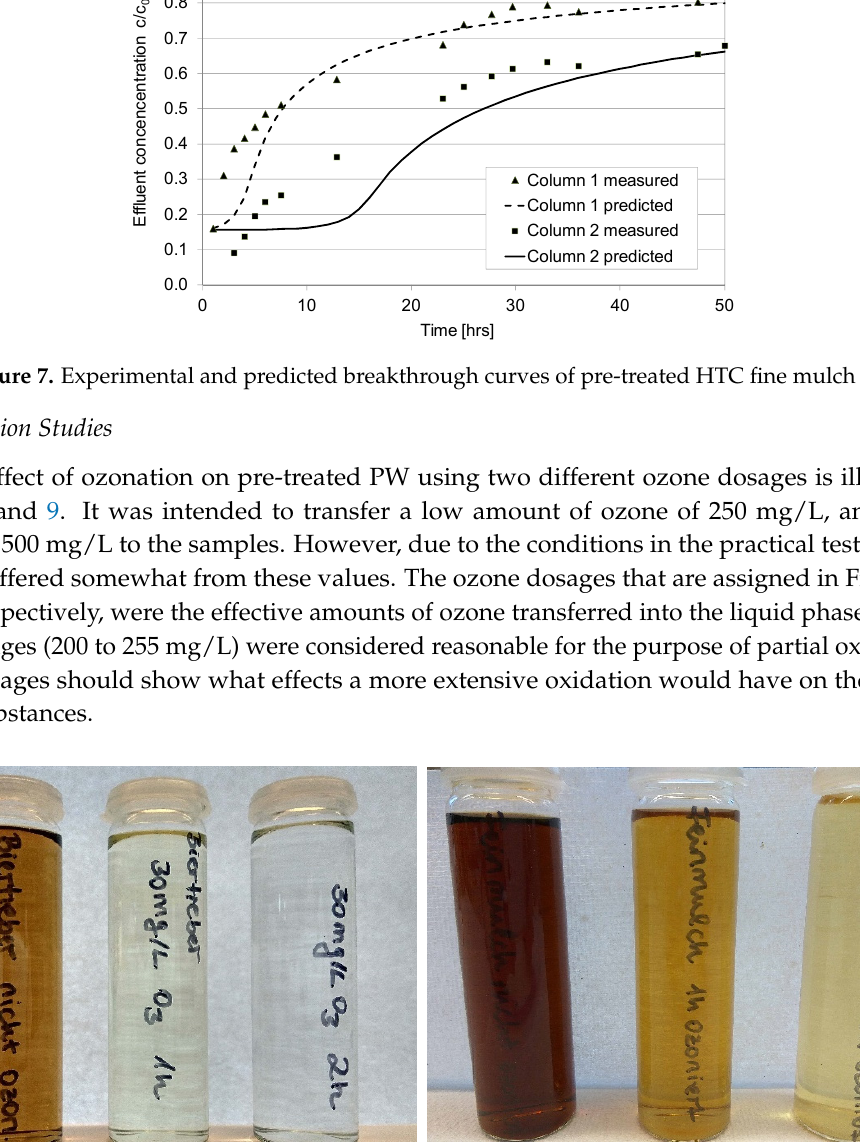
Figure 6. Experimental and predicted breakthrough curves of pre-treated HTC spent grains PW.